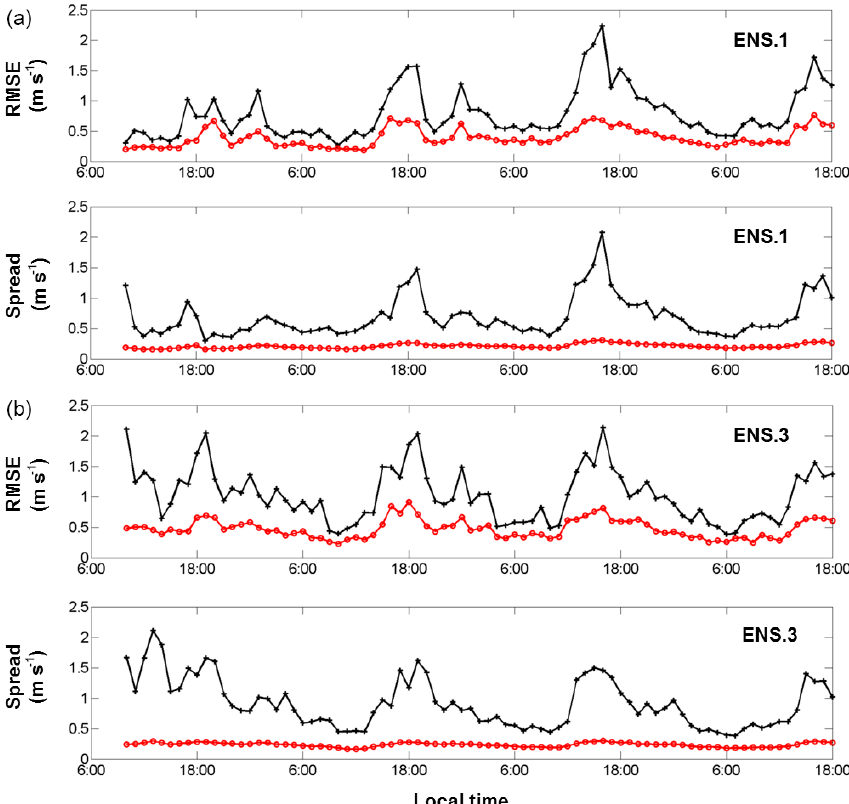
Figure 3. Time evolution of prior (black) and posterior (red) RMSEs and spreads of surface mesonet zonal wind observation in Denver from 2 July 10:00 to 5 July 18:00 for ENS.1 (a) and ENS.3 (b)